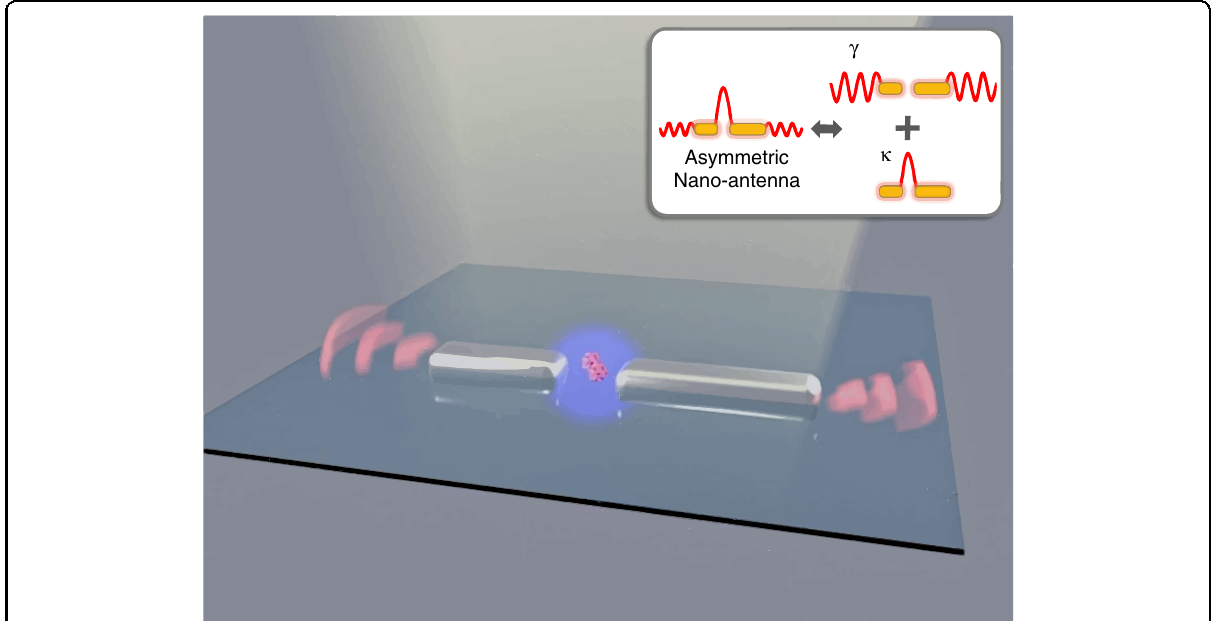
Fig. 1 Scheme of the fl orescence enhancement enabled by nano-antenna system. Florescence of molecule-antenna system is determined by both near- fi eld coupling ef fi ciency from molecule to antenna (purple sphere indicates near- fi eld distribution) and radiation capability from antenna to free space (red waves indicates far- fi eld distribution). Red-helix is molecule placed at the gap of antenna, yellow light beam represents the excitation illumination. Inset schematically depicts a typical plasmonic mode supported by our asymmetric nano-antenna, with far- fi eld part determining the radiation capability and near- fi eld part determining the molecule-antenna